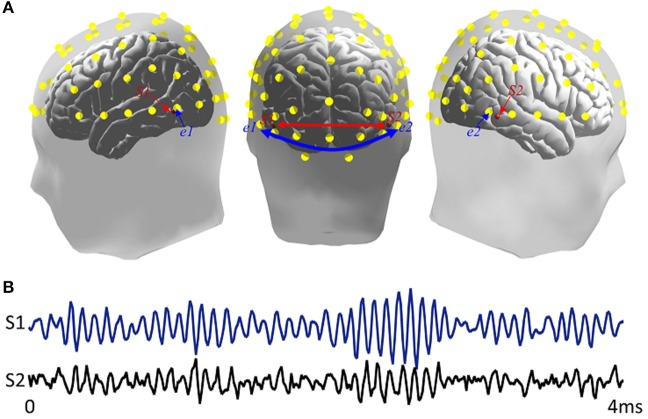
Simulation sources. (A) Locations of source and scalp channels in simulation design. S1 and S2 were two dipoles separately distributed in bilateral inferior temporal areas. e1 and e2 presented two scalp electrode channels. The head model comes from Brainstorm anatomy template ICBM512, (B) Time series of two simulated signals.